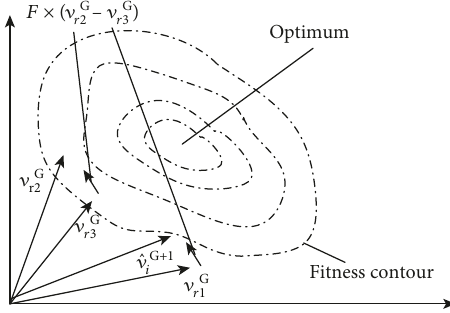
Figure 6: Mutation process of the DE algorithm.